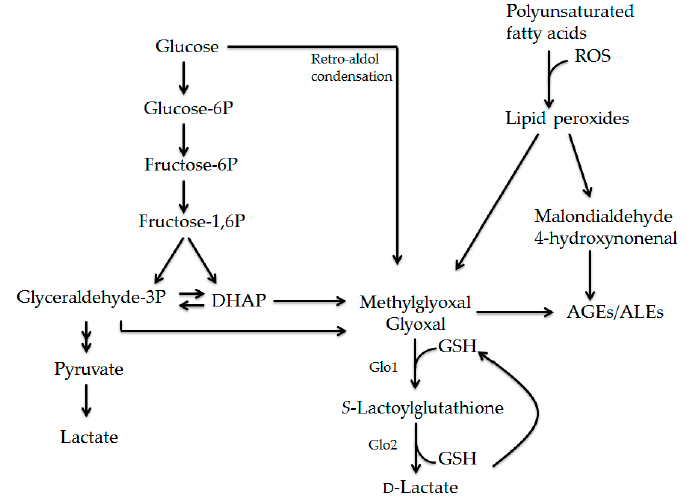
Figure 1. Formation of reactive dicarbonyl compounds and AGEs/ALEs via glucose and lipid intermediates. During glycolysis, glucose is converted into pyruvate and subsequently into lactate. Fragmentation of glyceraldehyde-3-phosphate (GAP) and dihydroxyacetone phosphate (DHAP) leads to the formation of methylglyoxal and glyoxal. In addition to glycolysis, lipid peroxidation of polyunsaturated fatty acids leads to the formation of lipid peroxides that can undergo fragmentation resulting in the formation of malondialdehyde, 4-hydroxynonenal, methylglyoxal, and glyoxal. Moreover, glyoxal can be directly created from glucose, via a retro-aldol condensation reaction. Incubation of these highly reactive compounds with proteins, lipids, and nucleic acids, leads to the fast formation of advanced glycation endproducts (AGEs) and advanced lipoxidation endproducts (ALEs). Methylglyoxal and glyoxal are detoxified via the glyoxalase system. First, methylglyoxal and glyoxal are converted to S -Lactoylglutathione by Glo1, which uses glutathione as a cofactor. Subsequently, S -Lactoylglutathione is metabolized to D -lactate by Glo-2. Glutathione gets recycled during this last step in the process.